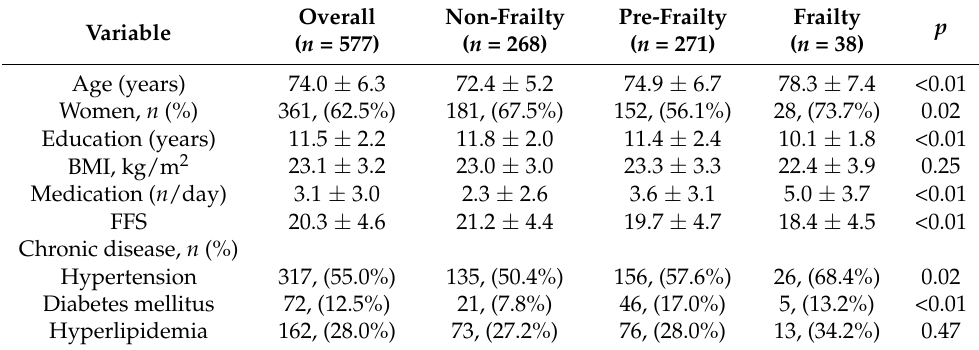
Table 1. Characteristics of the participants (mean ± or